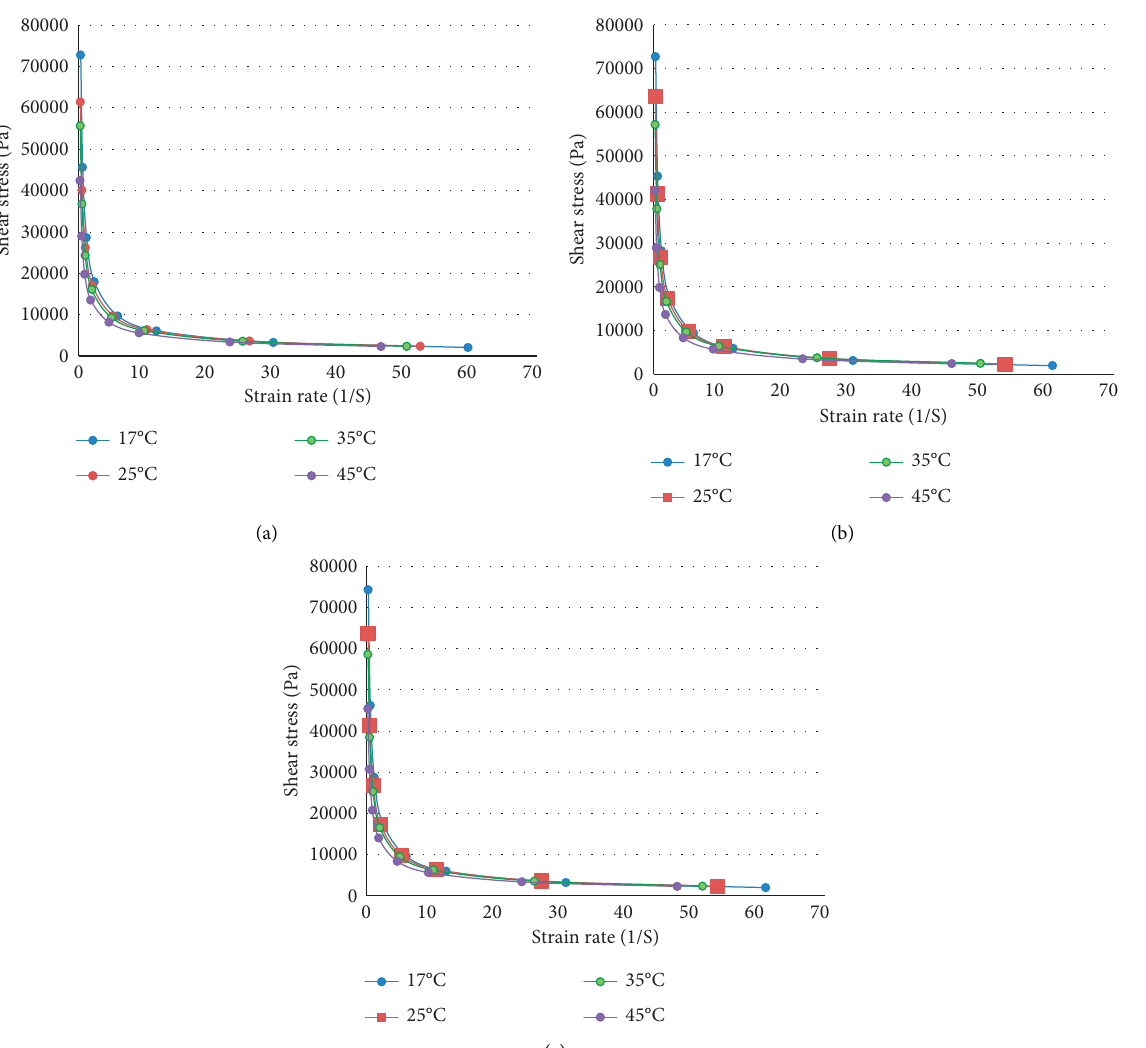
Figure 4: Apparent viscosity corrected with the Ostwald–De Waele model in the compote of Mespilus germanica L. with three replicates: repeat 1 (a), repeat 2 (b), and repeat 3